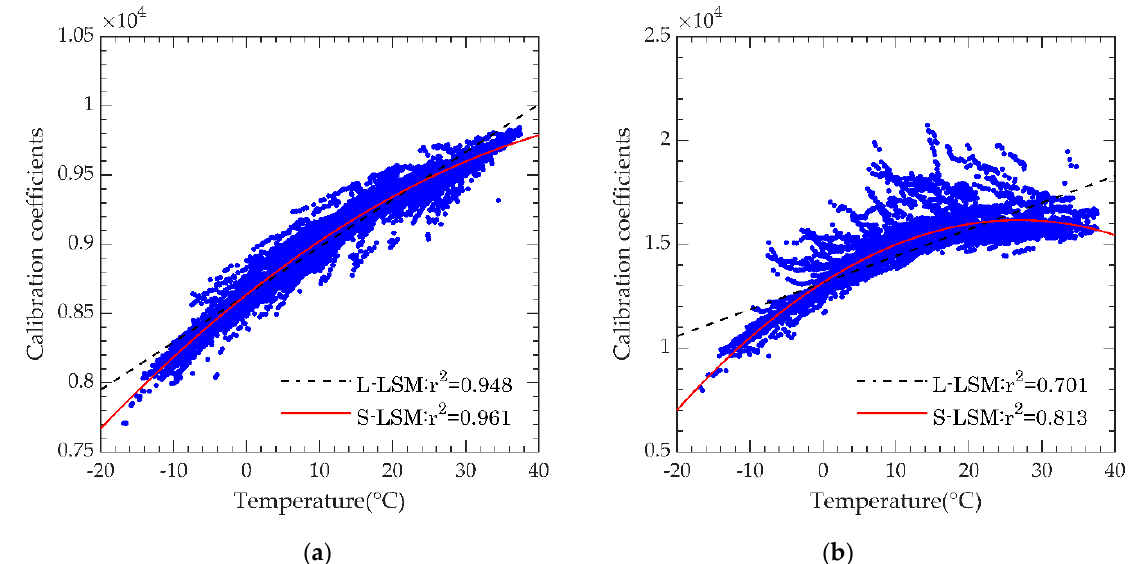
Figure 2. The calibration coefficients changing with temperature ( ℃ ) for a whole year: ( a ) 1020 nm; ( b ) 1639 nm. recalculate 0 b in Equation (10) for every month, after obtaining the temperature correction expression for a whole year. In addition, results are shown in Table 2. Table 2. Fitting results of 1020 nm and 1639 nm for every month in 2020.